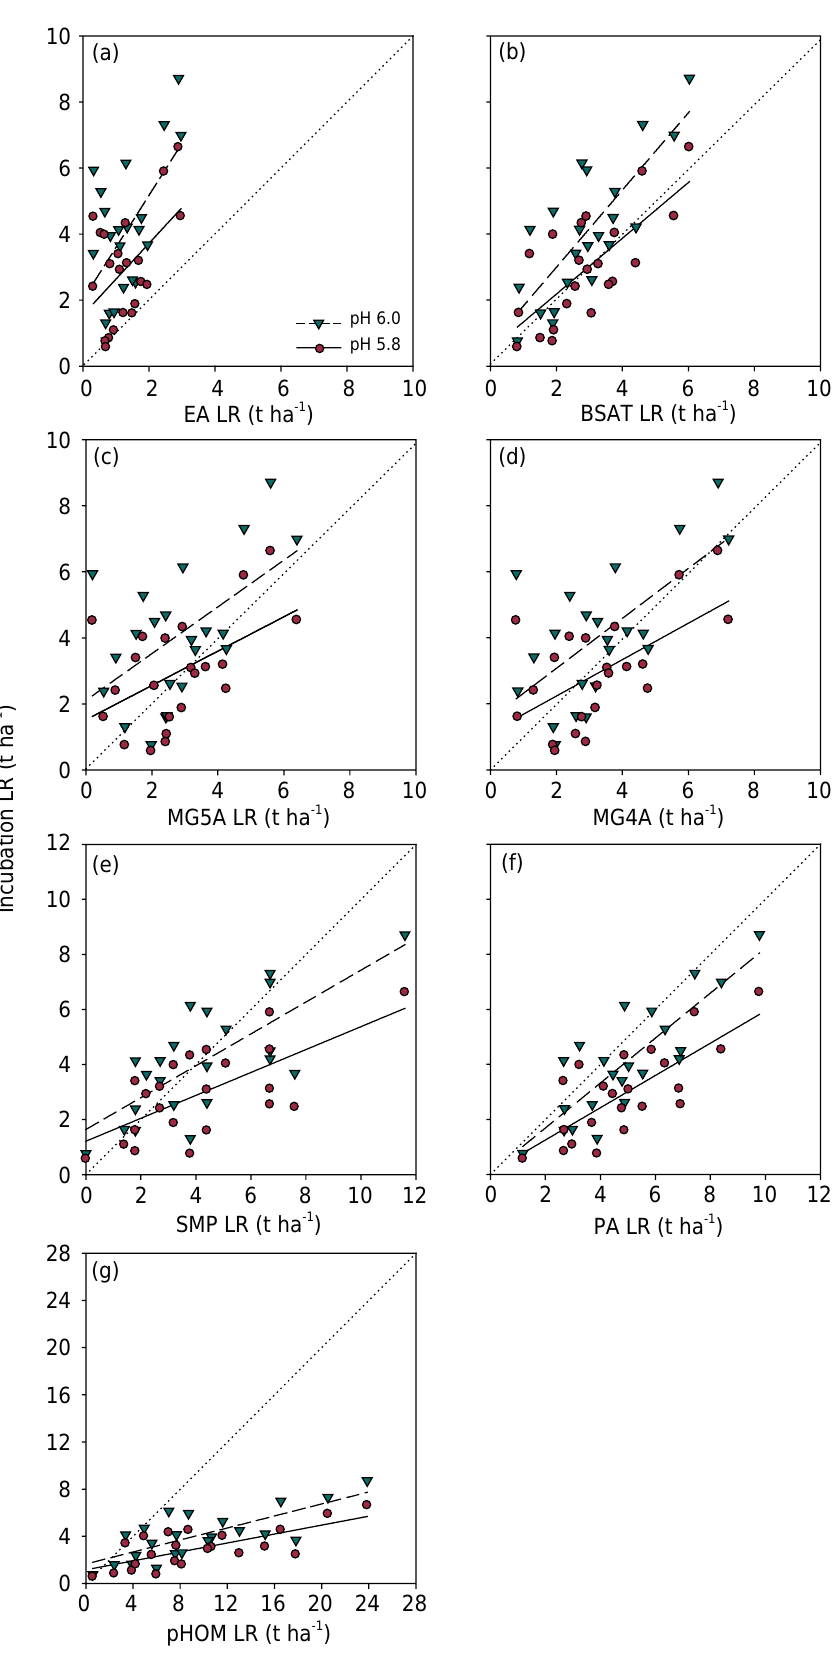
Figure 4. Relationships between lime requirement (LR) determined from the standard incubation method to raise soil pH to 5.8 and 6.0 and LR determined from the (a) exchangeable acidity (EA), (b) base saturation (BSAT), (c) 5th Approximation to the Minas Gerais State (MG) (MG5A), (d) 4th Approximation to MG (MG4A), (e) Shoemaker-McLean-Pratt buffer (SMP), (f) potential acidity (PA), and (g) soil pH-organic matter (pHOM) methods. The dotted line indicates the 1:1 ratio between methods. Regression parameters are shown in table